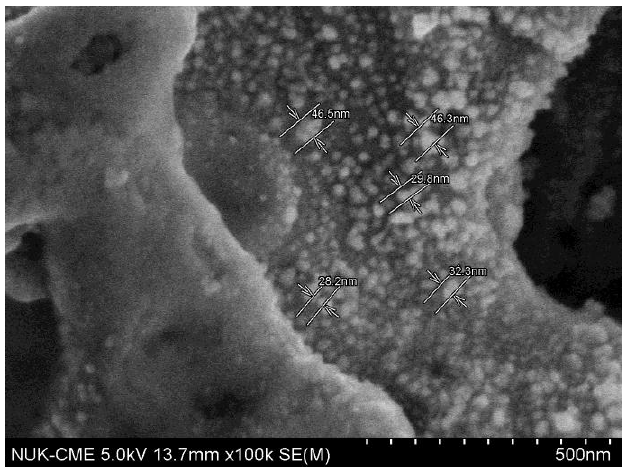
Figure 2. The appearance and particle size of the surface treated by plasma electrolysis.